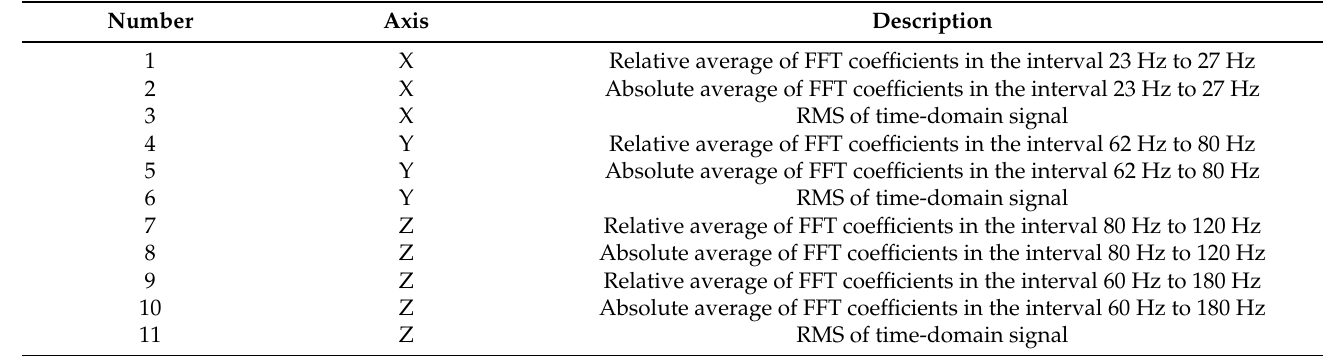
Table 1. Feature set for classification of physical activity based on 3-axis accelerometer data of a cage mounted inertial measurement